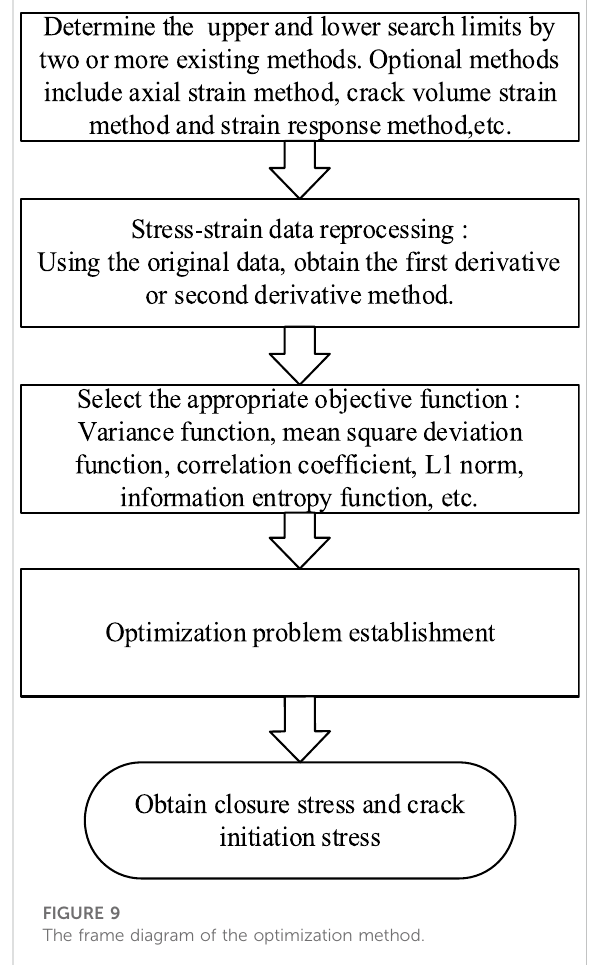
FIGURE 9 The frame diagram of the optimization